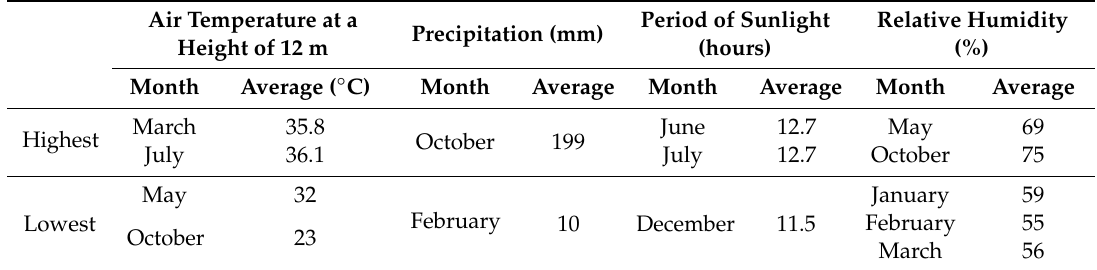
Table 5. Environmental conditions of the department of